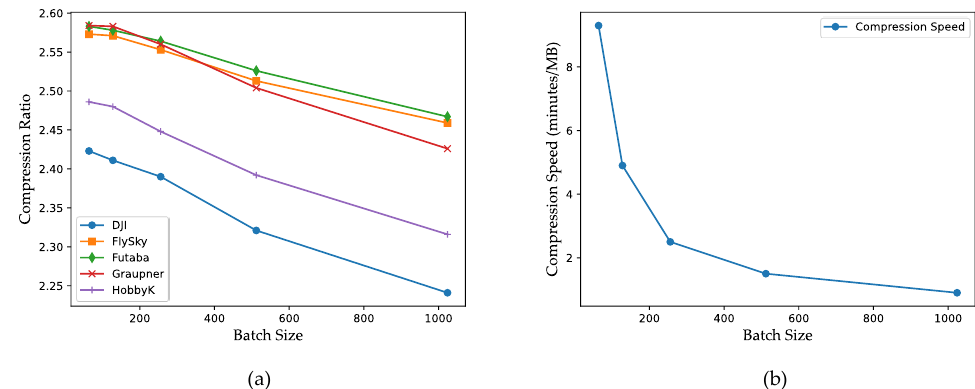
Figure 3. The relationship between the batch size and ( a ) the compression ratio; ( b ) the average compression